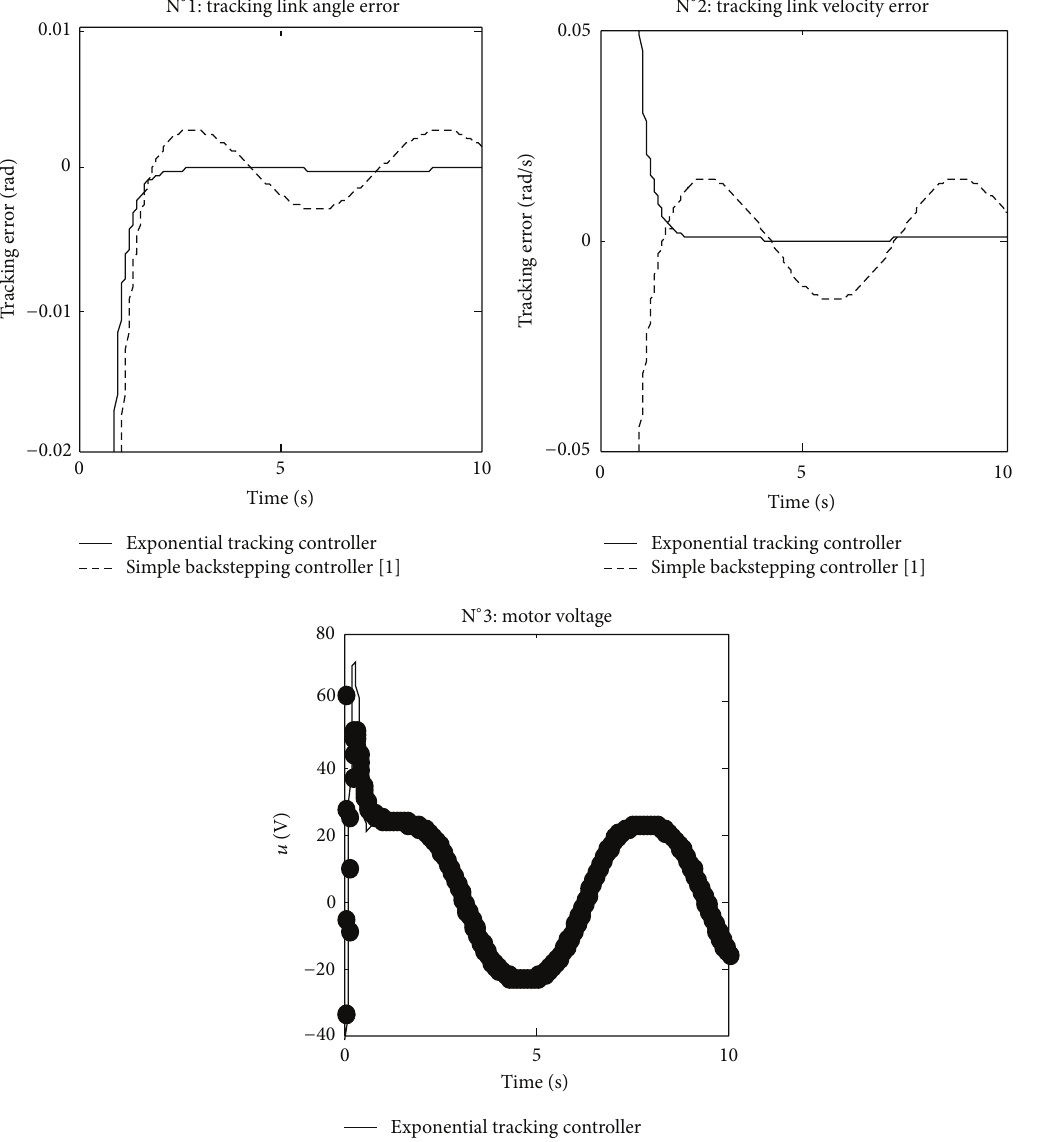
Figure 3: Comparative performance in tracking sine